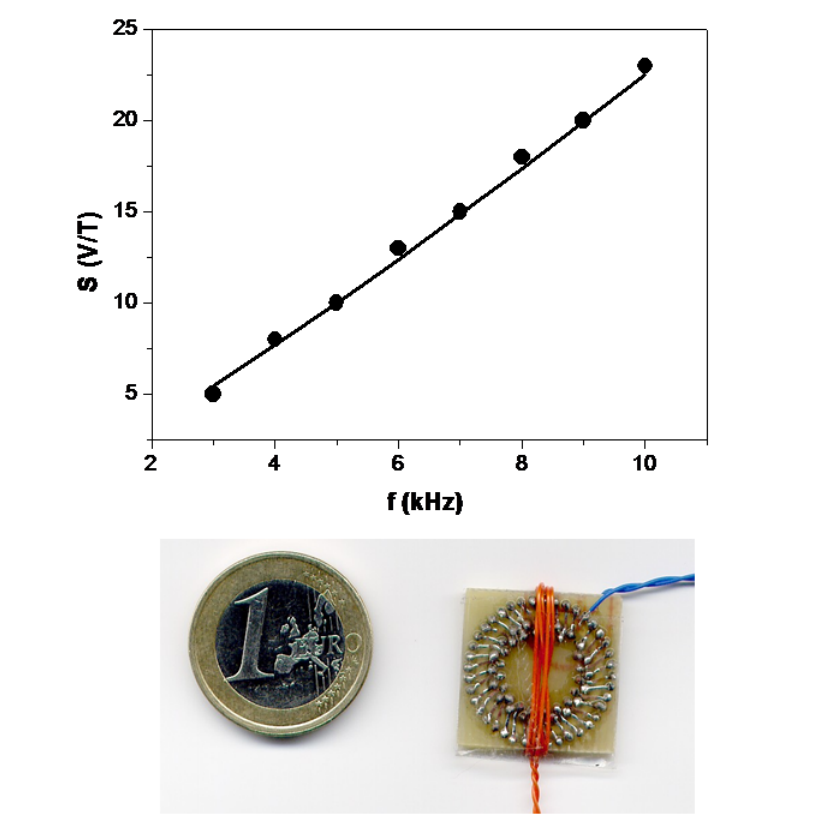
Figure 2 . Sensitivity vs . frequency of former planar fluxgate developed by GDM´s group. Picture of a former version.